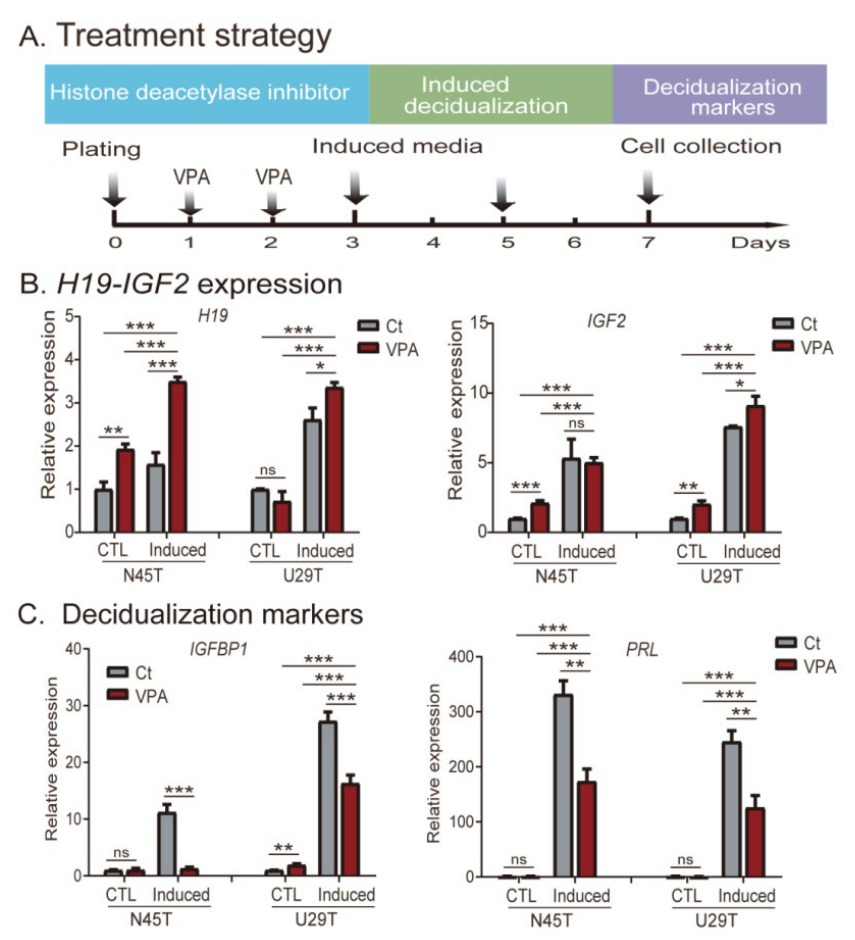
Figure 3. The role of disturbed epigenetics in in vitro decidualization. ( A ) Strategy of inducing epige- netic disturbance by the histone deacetylase inhibitor VPA in primary cultures of endometrial cells. Cells were pretreated with VPA and then were induced for in vitro decidualization. ( B ) Expression of H19 and IGF2 in decidualized endometrial cells. VPA: cells treated with the histone deacetylase inhibitor valproic acid. Ct: cells treated with PBS control. Induced: in vitro induction of decidualiza- tion. CTL: PBS-treated control cells. ( C ) Expression of two decidualization markers IGFBP1 and